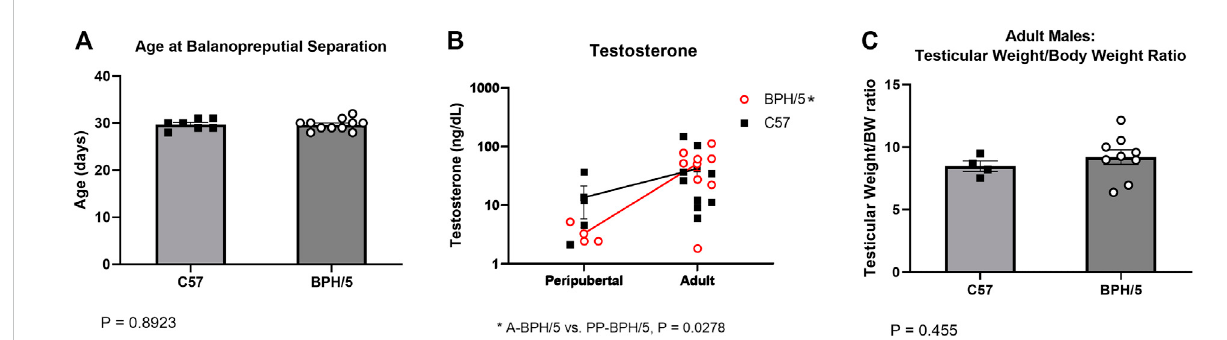
FIGURE 2 Precocious pubertal development does not occur in BPH/5 male offspring. (A) Age at the day of balanopreputial separation in peripubertal BPH/ 5 and C57 male offspring ( n = 7 – 11/group, Student ’ s t-test, mean ± SEM, p = 0.8923). (B) Serum testosterone concentration in peripubertal and adult BPH/5 and C57 males ( n = 3 – 9/group, Two-way ANOVA, post hoc Tukey ’ s test, mean ± SEM, * p = 0.0278 in adult BPH/5 vs. peripubertal BPH/5). (C) Combinedtesticularweight(i.e.,bothtestes)correctedbybodyweight(Testicularweight/BW ratio)inadultBPH/5malesandagematchedC57( n =